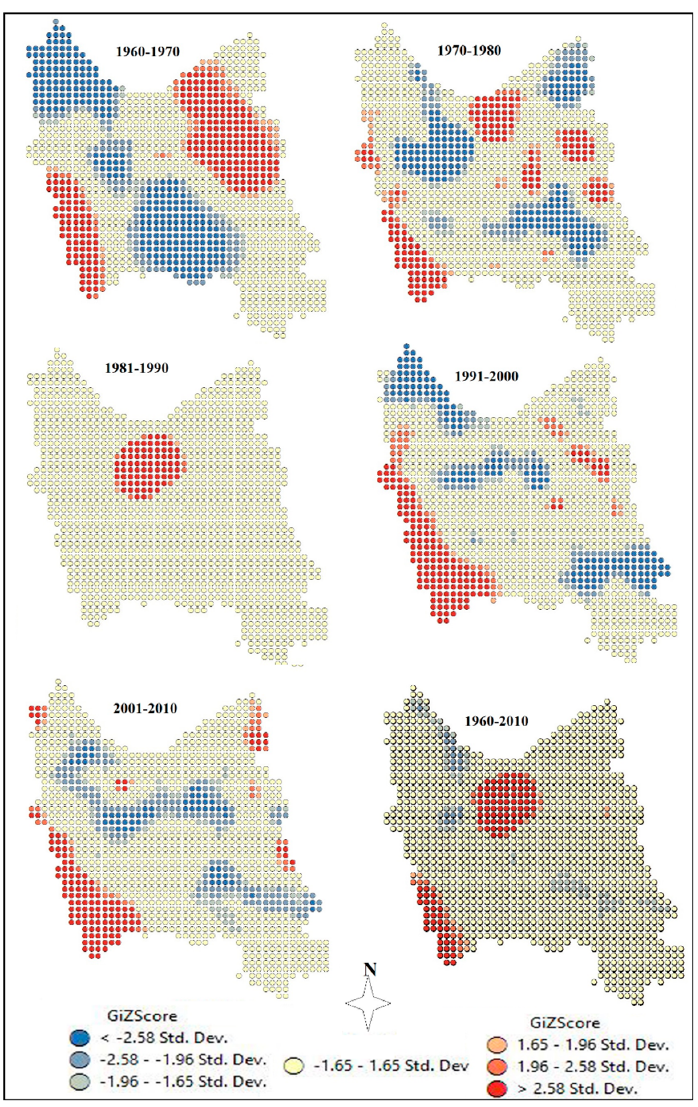
Figure 3. Spatial autocorrelation pattern of extreme precipitation thresholds in the northwest of Iran based on the spatial index of Gi . Table 3. Percentage of area covered with spatial autocorrelation pattern of extreme precipitation threshold in the northwest of Iran based on the spatial index of Gi .